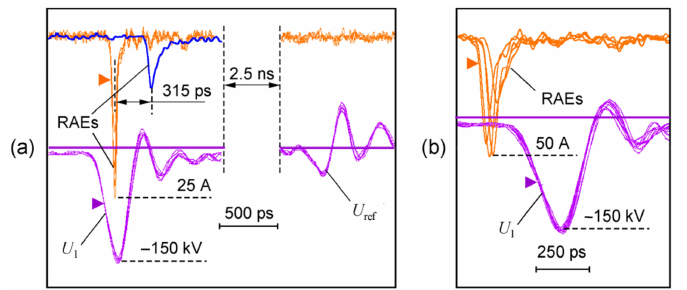
Figure 7. Measurement of the RAE emission temporal stability at D = 30 mm. The collector has a diameter of 9 mm. Five consecutive pulses are presented. ( a ) Graphite cathode. The total beam current is 22 ± 4.5 A. The leading edge and duration (FWHM) of the current are ≈ 30 ps and ≈ 45 ps, respectively. Delayed RAE current pulse is shown for the time-of-flight estimation of the particle energy. ( b ) Increased emission time spread in the case of a steel